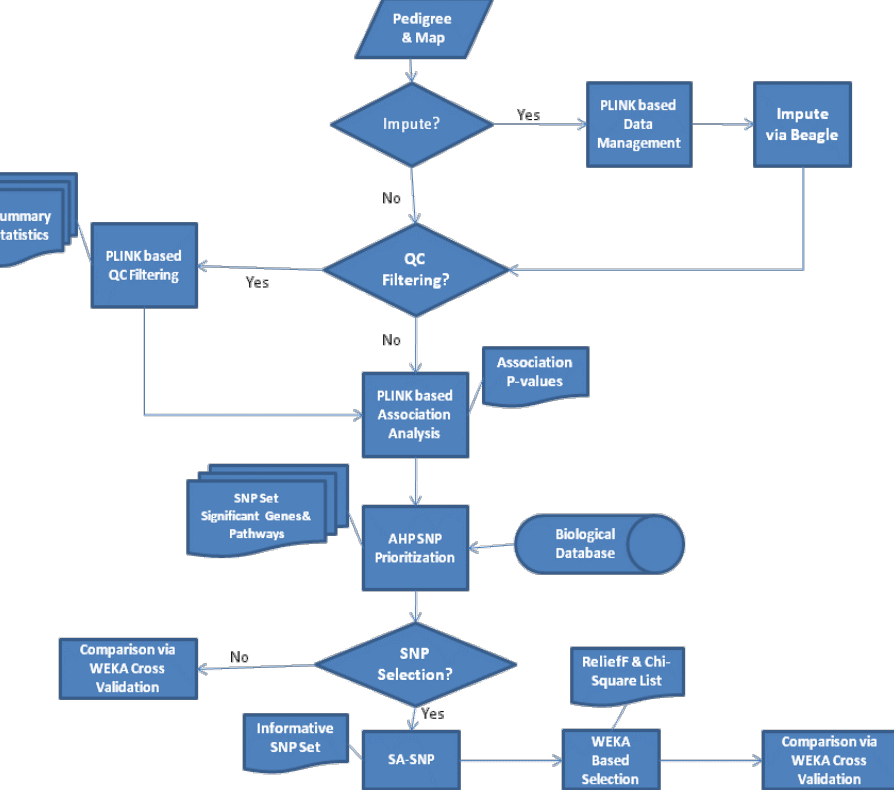
Figure 4: Logic flow of METU-SNP software